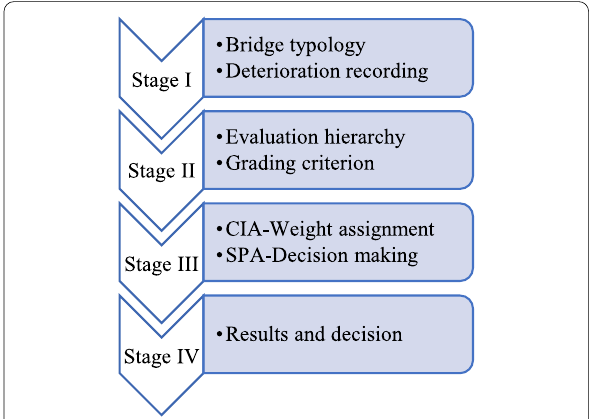
Fig. 1 Methodological scheme of structural safety